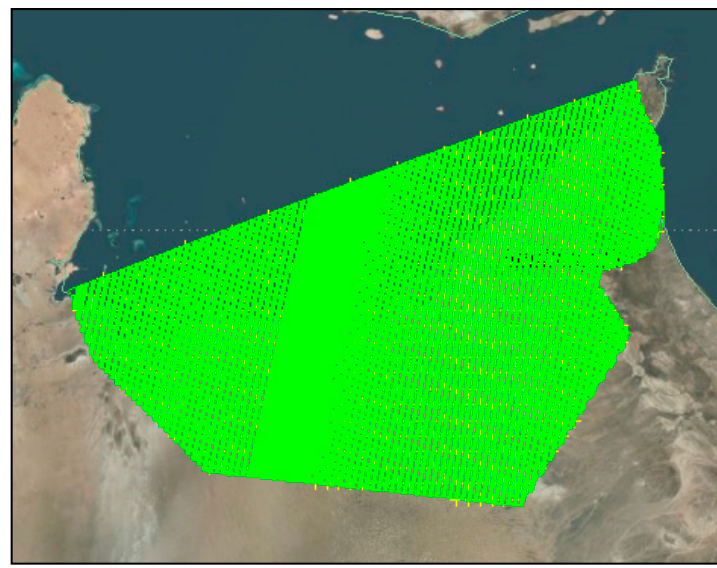
Figure 15. Spectrometer footprint coverage analysis for 36-month.